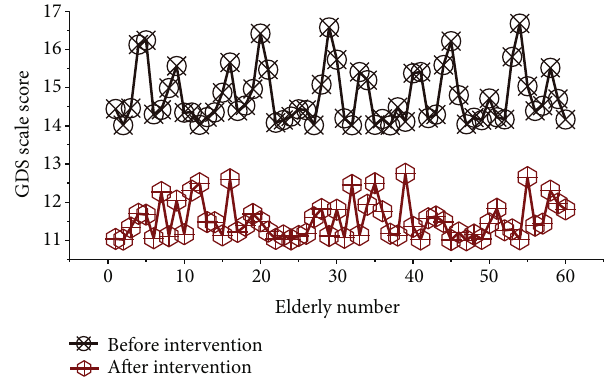
Figure 5: Comparison of GDS scale scores of depression level before and after psychological intervention for the elderly in the